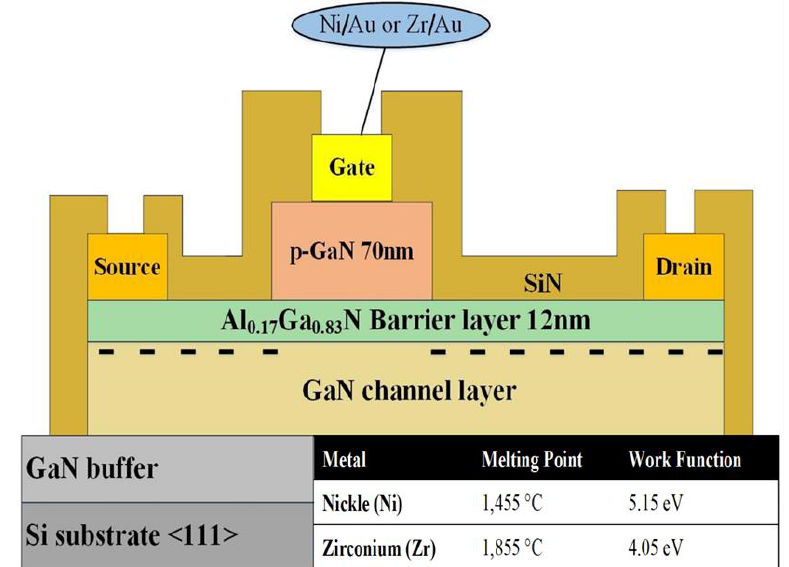
Figure 1. Schematic of the E-mode p-GaN / AlGaN / GaN high-electron-mobility-transistor (HEMT) with a different gate metal.